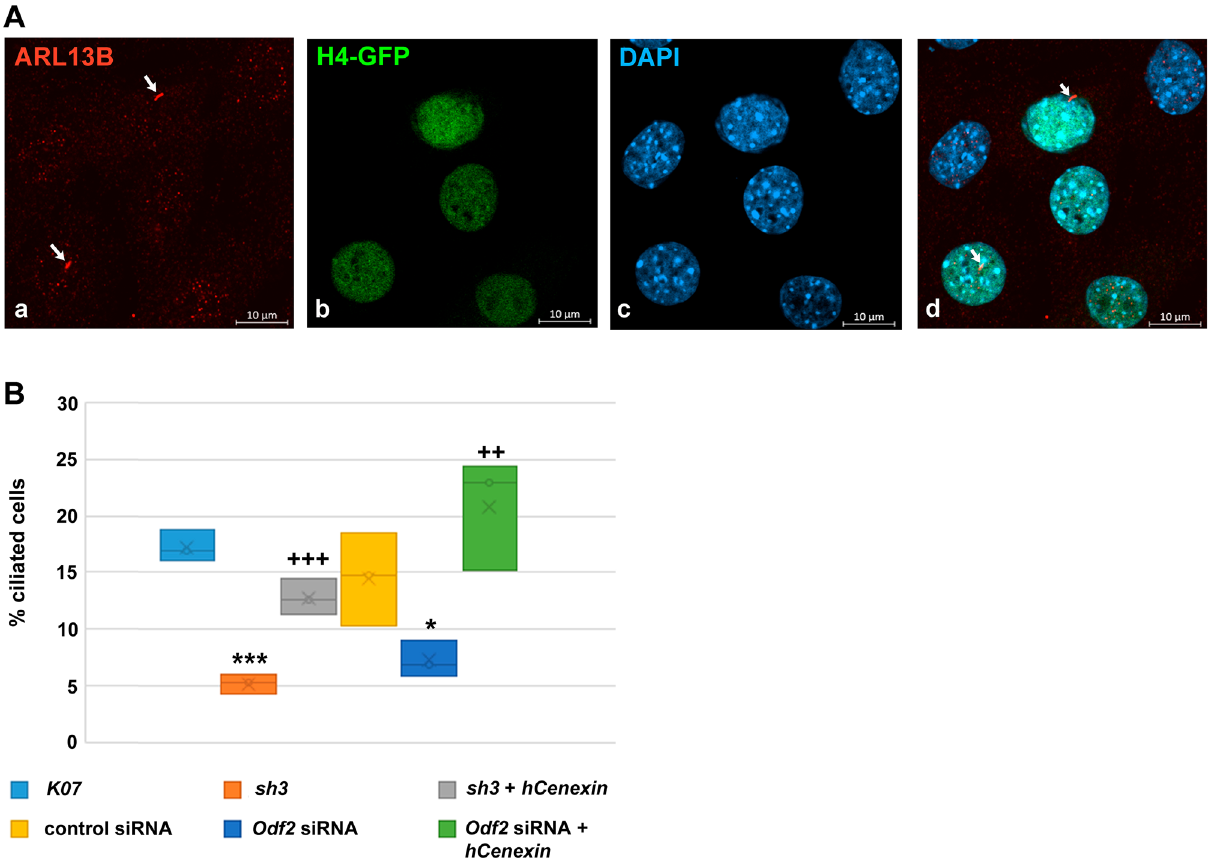
Figure 1. ODF2 is essential for primary cilia formation. ( A ) Exemplary presentation of ciliated NIH3T3 cells. Only transfected cells, whose nuclei stained green because of histone H4::GFP expression, were considered for ciliary counting. Cells were transfected with histone H4::gfp ( b , green) and decorated for primary cilia with anti-ARL13B staining ( a , red, arrows). Nuclei were stained with DAPI ( c , blue), and the merged image is shown in d (cilia are marked by arrows). Scale bars in a–d of 10 µm. ( B ) The percentage of transfected cells that are ciliated is strongly decreased when Odf2 was knocked down by transfection of either the short hairpin plasmid sh3 or Odf2 siRNA compared to the controls, plasmid K07 or control siRNA, respectively. Co-transfection of the non-targeted hCenexin with either sh3 or Odf2 siRNA rescued primary cilia formation. Student’s T-test (one-tailed, homoscedastic): p < 0.05 * or + , p < 0.01 ** or ++ , p < 0.001 *** or +++ . Symbols represent comparison to either the respective controls ( K07 or control siRNA) * or to the respective knockdown ( sh3 or Odf2 siRNA) + . Biological triplicates with a total of n counted cells: K07 n = 1,621, sh3 n = 1,591, sh3 + hCenexin n = 1,593, control siRNA n = 1,509, Odf2 siRNA n = 1,538, Odf2 siRNA + hCenexi n n = 1,580. P -values: sh3 to K07 : p = 0.000114***, sh3 + hCenexin to sh3 p = 0.000989 +++ , Odf2 siRNA to control siRNA p = 0.022857*, and Odf2 siRNA + hCenexin (rescue) to Odf2 siRNA p = 0.005358 ++ fection ( p = 0.001565**), but not by co-transfection of Foxo1 , Foxo3a , Foxj1 , or co-transfection of both, Foxj1 and Rfx3 (Fig. 2A). Additionally, our previous results reporting transcriptional activation by C/EBPα, and the JNK-pathway (MEKK1 + cJUN) were verified. The co-transfection of Foxa1 with either C/ebpα , Mekk1 , cJun or combinations of these factors revealed that FOXA1 together with C/EBPα has no additive effect on the reporter activity compared to C/EBPα. FOXA1 together with MEKK1 significantly increased the reporter gene activity compared to FOXA1 ( p = 0.026646*), but without further increase when compared to MEKK1. FOXA1 together with cJUN increased the reporter gene activity to a similar extent as MEKK1-activated cJUN, and significantly ( p = 2.84466 × 10 –5 ****) when compared to FOXA1. The co-transfection of Mekk1 , cJun , and Foxa1 caused a further significant upregulation of the reporter activity compared to cJUN ( p = 0.004115**), cJUN + MEKK1 ( p = 0.0002307***), and FOXA1 ( p = 3.37212 × 10 –10 ****). These data indicated a positive interaction between FOXA1 and cJUN in the transcriptional activation of Odf2 that is reinforced by MEKK1-mediated activation of cJUN. According to Student’s T-test, the co-expression of all four factors, MEKK1, cJUN, C/EBPα, and FOXA1 did not significantly increase the reporter gene activity compared to the co-expression of these factors but with- out FOXA1. The combination of FOXA1 with cJUN and C/EBPα did not cause an up-regulation of reporter gene activity as compared to FOXA1 alone. Since cilia formation is stimulated by serum starvation-induced cellular quiescence simultaneously with enhanced Odf2 promoter activity 47 we wondered whether FOX TFs are also activated by serum starvation. The